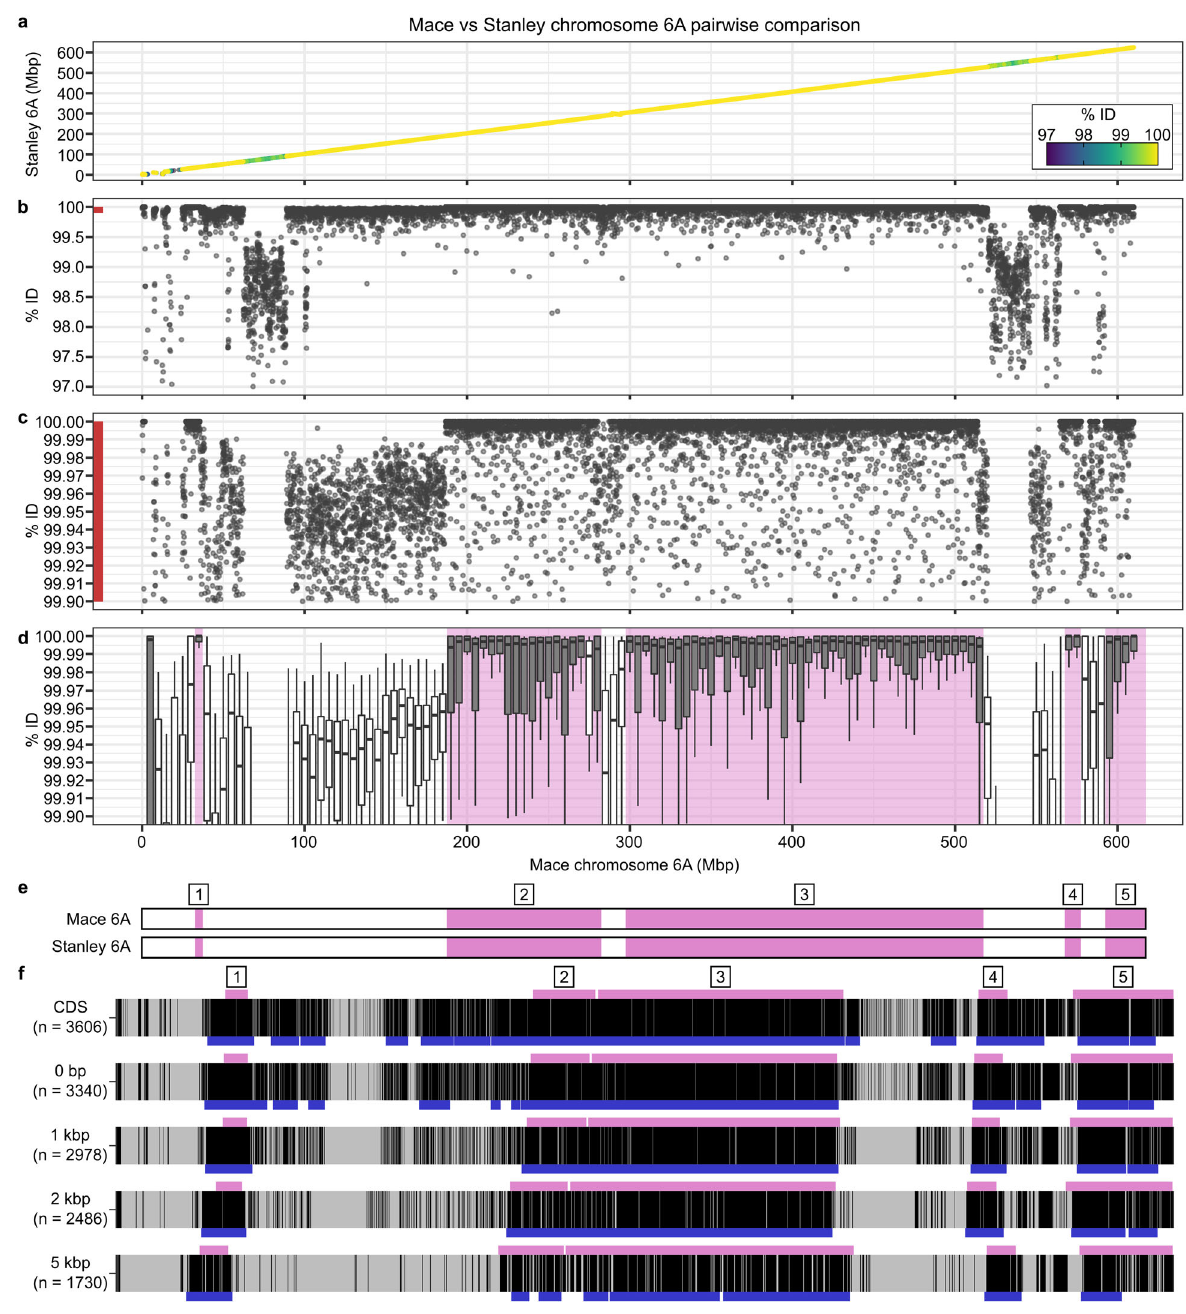
Fig. 1 De fi nition of haplotype blocks using Mace and Stanley chromosome 6A as an illustrative example. a NUCmer alignments ( ≥ 20 Kbp length) between chromosome 6A (chr6A) of the Mace and Stanley assemblies. Each data point represents a single pairwise alignment, with the position corresponding to the midpoint of the alignment with respect to the Mace ( x -axis) and Stanley ( y -axis) assemblies. b % sequence identity of the pairwise NUCmer alignments between chr6A of Mace and Stanley in ( a ) with respect to the position in the Mace assembly. Each data point represents a single pairwise alignment. c Close-up view of ( b ) (red bar) between 99.90 and 100.00 % sequence identity. d Boxplots show the pairwise NUCmer alignments between chr6A of Mace and Stanley from ( b ) grouped into 5-Mbp bins. Grey- fi lled boxplots indicate bin median ≥ 99.99% sequence identity. Pink-shaded regions indicate intervals de fi ned as haplotype blocks using the NUCmer-based approach (adjacent bins with median ≥ 99.99% stitched together allowing for two bins below the threshold, see “ Methods ” ). e Diagrammatic representation of haplotype blocks between Mace and Stanley on chr6A called in ( d ). Mace physical position is a common axis for ( a – e ). f Pairwise BLAST alignments of genes on chromosome 6A in Mace and Stanley based on projections of RefSeqv1.1 high-con fi dence gene models (ordered by RefSeqv1.1 coordinates). The amount of fl anking sequence included is indicated on the left, n indicates number of genes (sequences with Ns were excluded). Black = 100% identity, grey = <100% identity. Numbered boxes/pink rectangles above the heatmaps show the locations of NUCmer-based haplotype blocks de fi ned in ( e ). Blue boxes below the heatmaps are haplotype blocks called based on BLAST alignments (25-gene sliding window; see “ Methods ”